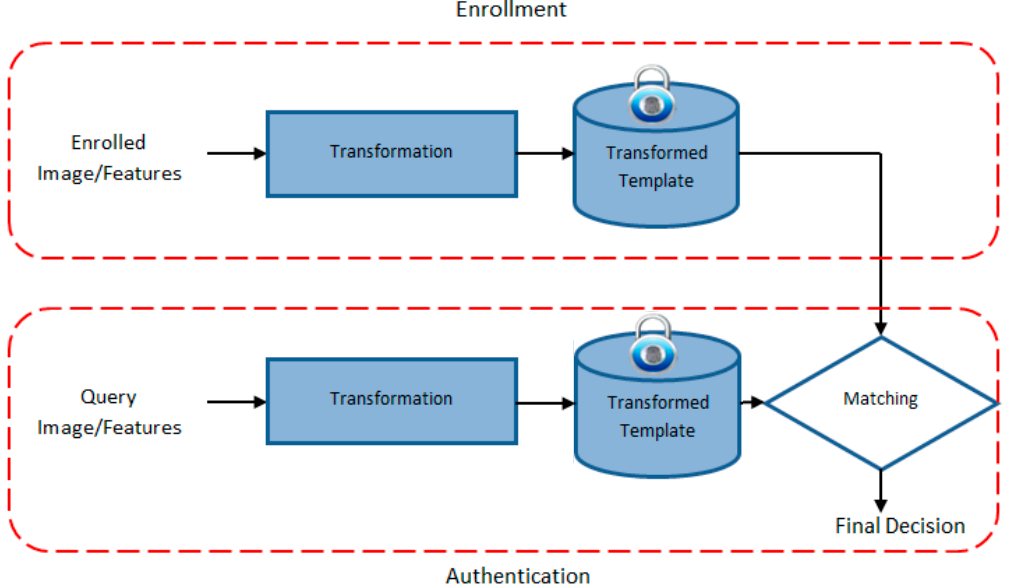
Figure 1. Cancelable biometric recognition system.